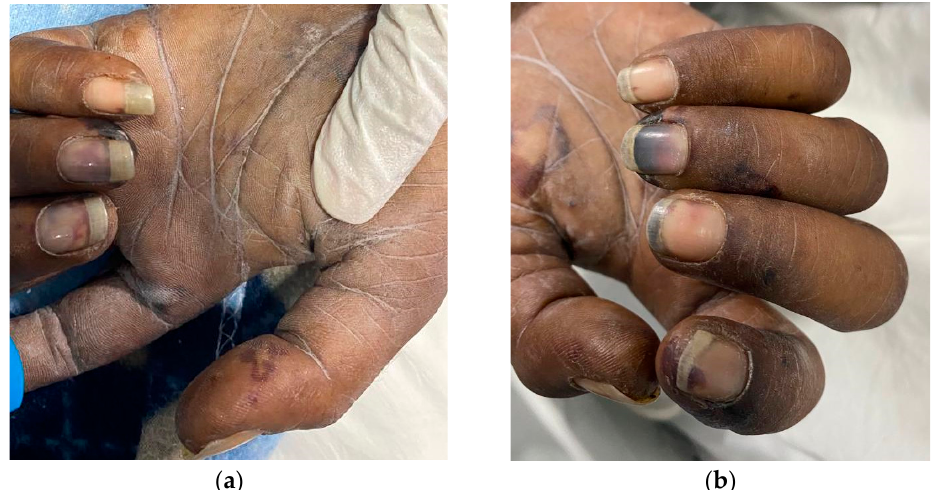
Figure 1. Peripheral stigmata of IE. ( a , b ) Both the left and right hands showed multiple Janeway lesions and splinter hemorrhages.